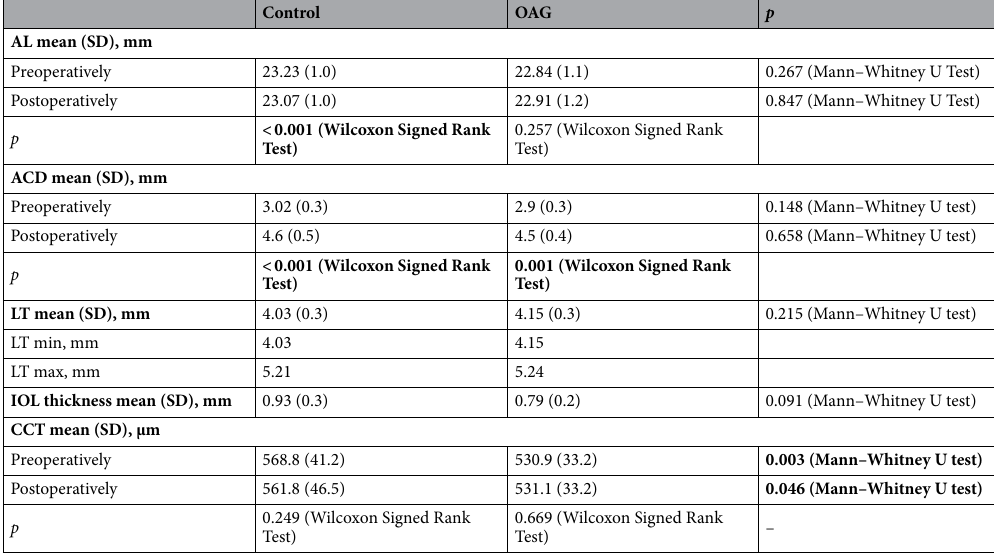
Table 3. Biometry results pre- and postoperatively (Significance in bold). AL axial length (mm) pre- and postoperatively, ACD anterior chamber depth (mm) pre-and postoperatively, LT (mm) lens thickness mean, as well as minimum and maximum values in each group, IOL thickness (mm) intraocular lens thickness, CCT (mm) central corneal thickness (μm) pre- and postoperatively.